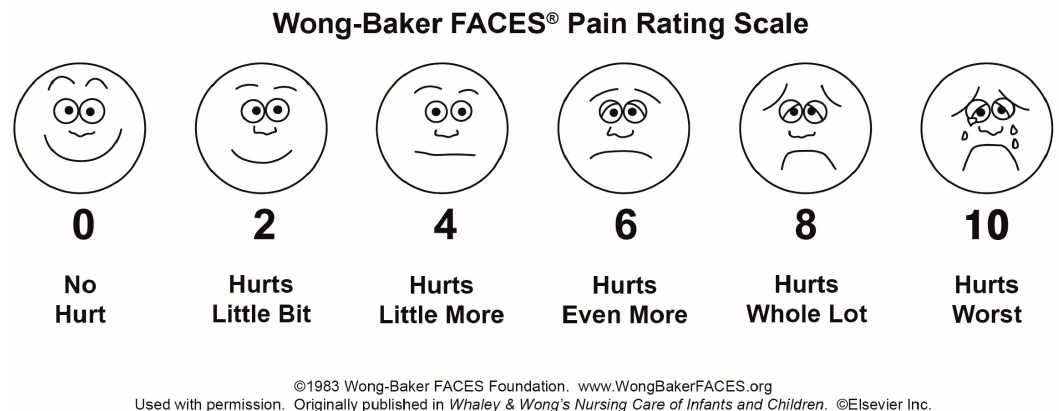
Figure 1. Wong-Baker’s FACES pain rating scale (used with permission).